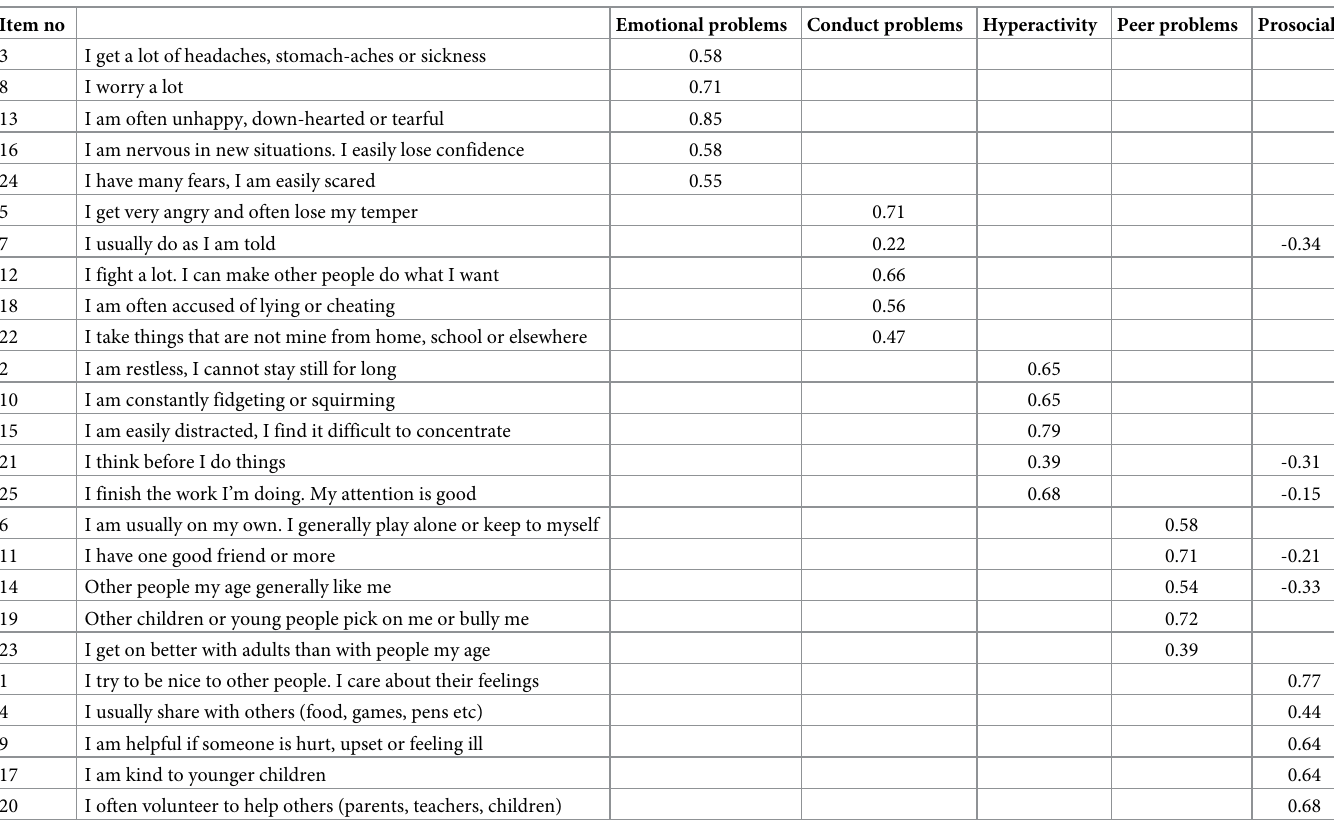
Table 3. Completely standardized factor loadings from a 5-factor model with cross-loadings for positively worded difficulties items on the prosocial scale and minor factors (model 8a).